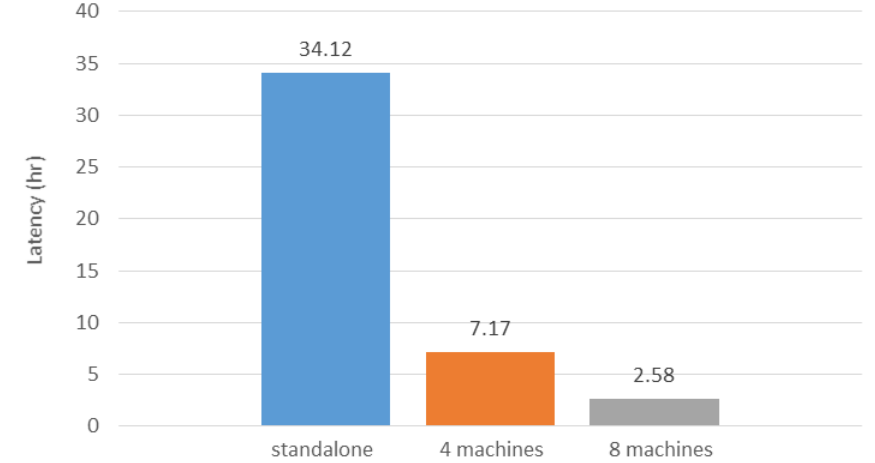
Figure 12. Performance comparison between standalone and parallel processing.